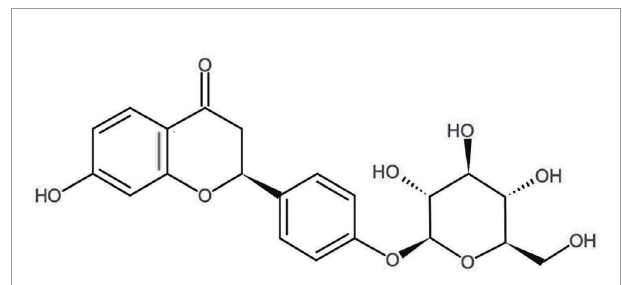
FIGURE 1 | The chemical structure of Liquiritin (LQ, C 21 H 22 O 9 ). The chemical class is fl